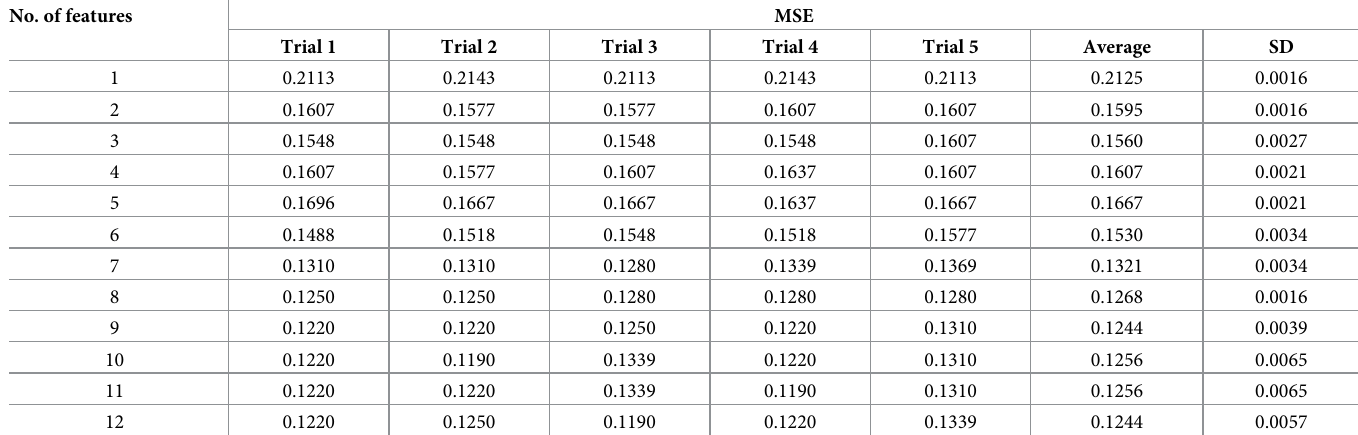
Table 3. Estimates of MSE of different number of features.